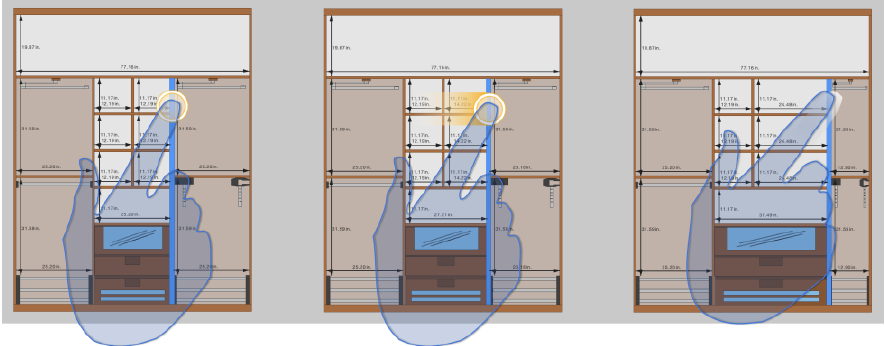
Figure 9. Indirect scaling application example. The algorithm modifies in real time the scale of the compartments adjacent to the horizontal division translated.